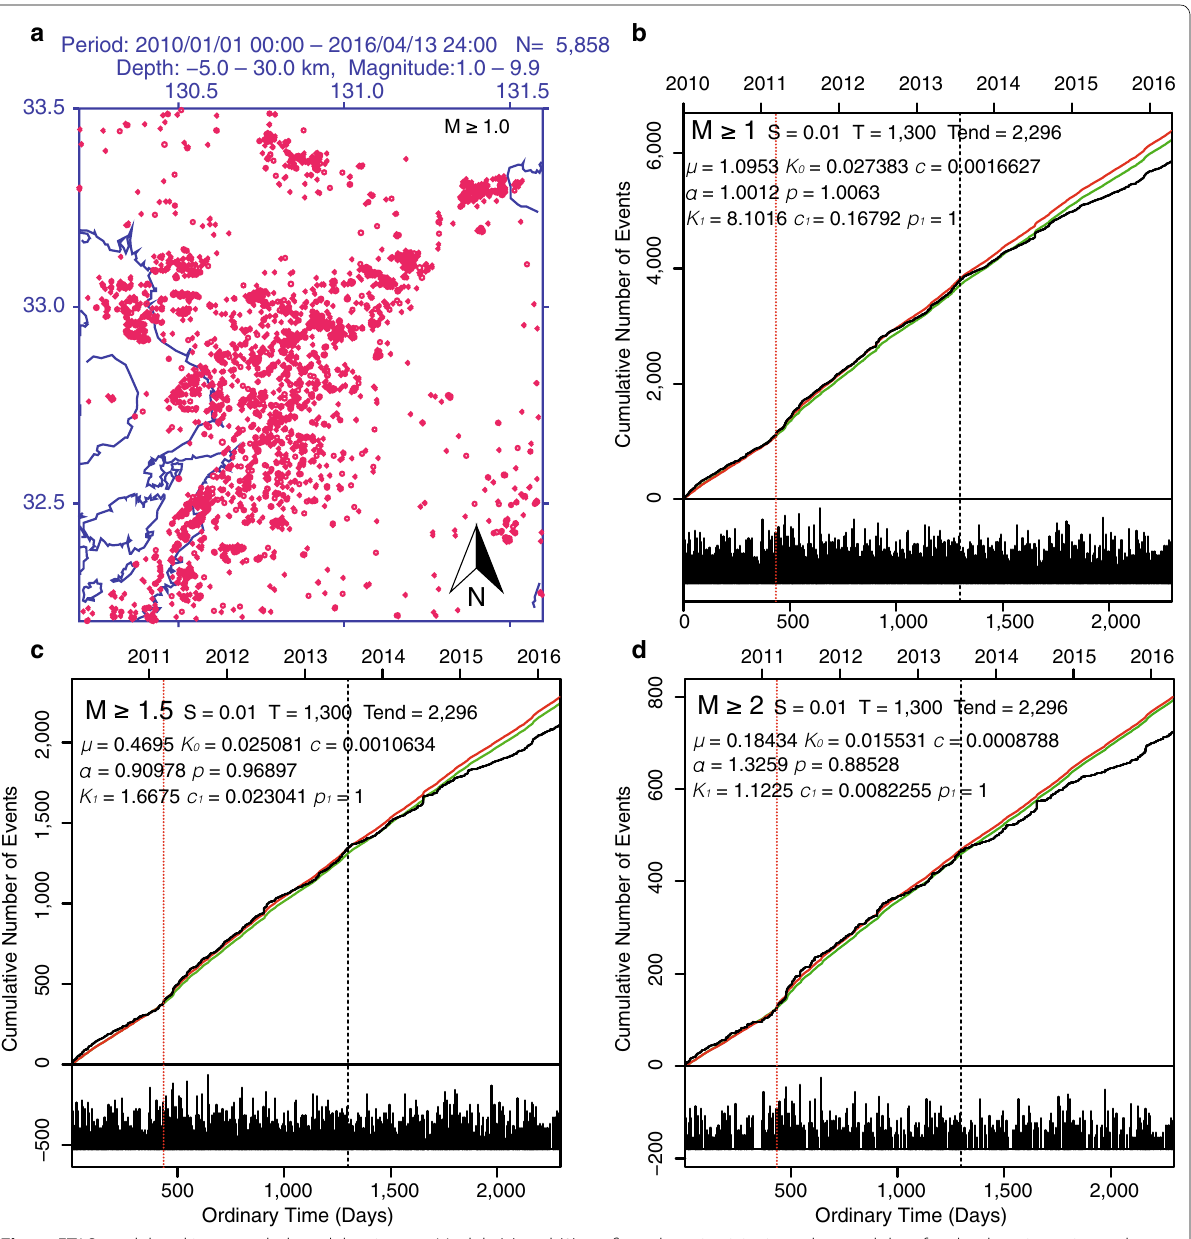
Fig. 1 ETAS model and its extended model estimates. Models (1) and (2) are fit to the seismicity in and around the aftershock region prior to the M6.5 Kumamoto earthquake. a Seismicity from 2010 until the M6.5 earthquake with a cutoff magnitude of M c ted to the datasets until the change-point (the dashed vertical line) with M c when the M9.0 Tohoku-Oki earthquake (March 11, 2011) occurred. The green and red cumulative curves of models (1) and (2) are extended for the period until the M6.5 event and are superimposed onto the observed cumulative curve (black curve). The corresponding M–T plots are attached in the bottom